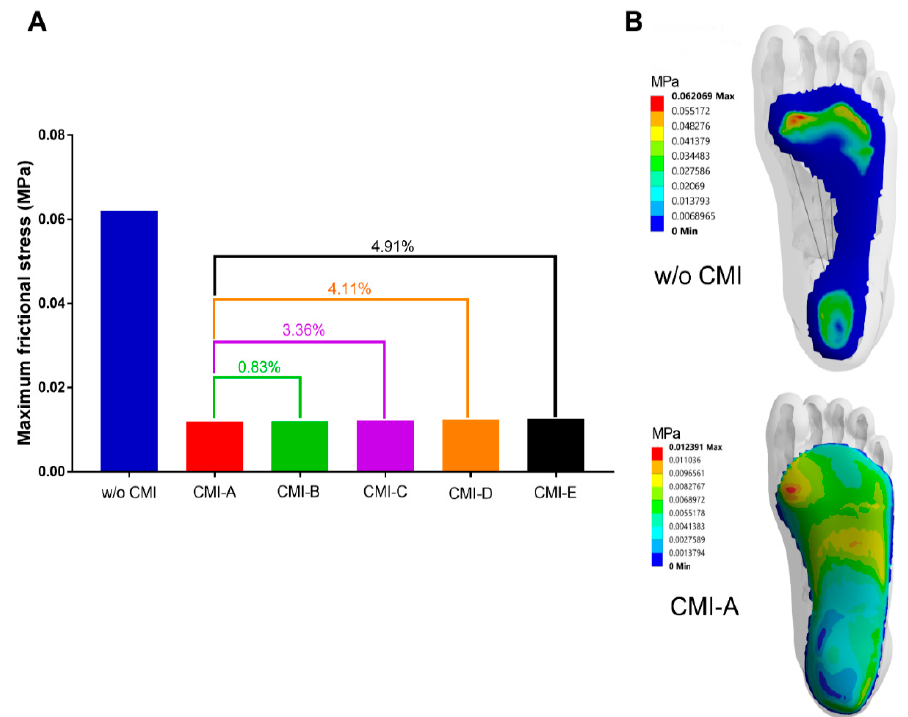
Figure 5. ( A ) The finite element analysis (FEA) results for the maximum frictional stress obtained from different CMI materials varied from soft to hard compared to without CMI, and ( B ) the comparison of frictional stress obtained from FEA in the case of without and with CMI fabricated from EVA using a single layer of softer material.